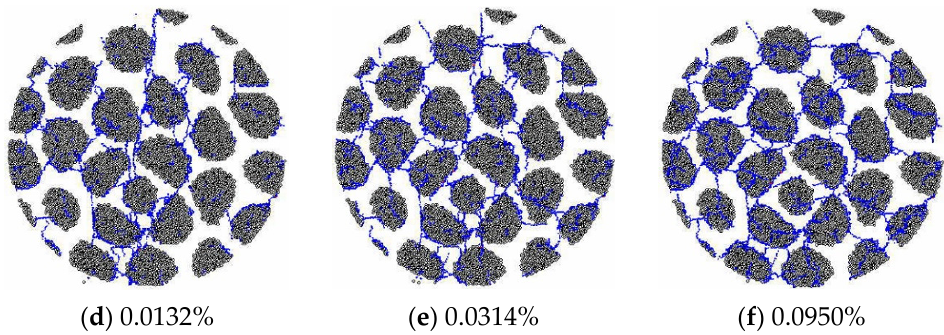
Figure 10. Microcrack morphology in the failure state of the specimen GC20-1.5%.